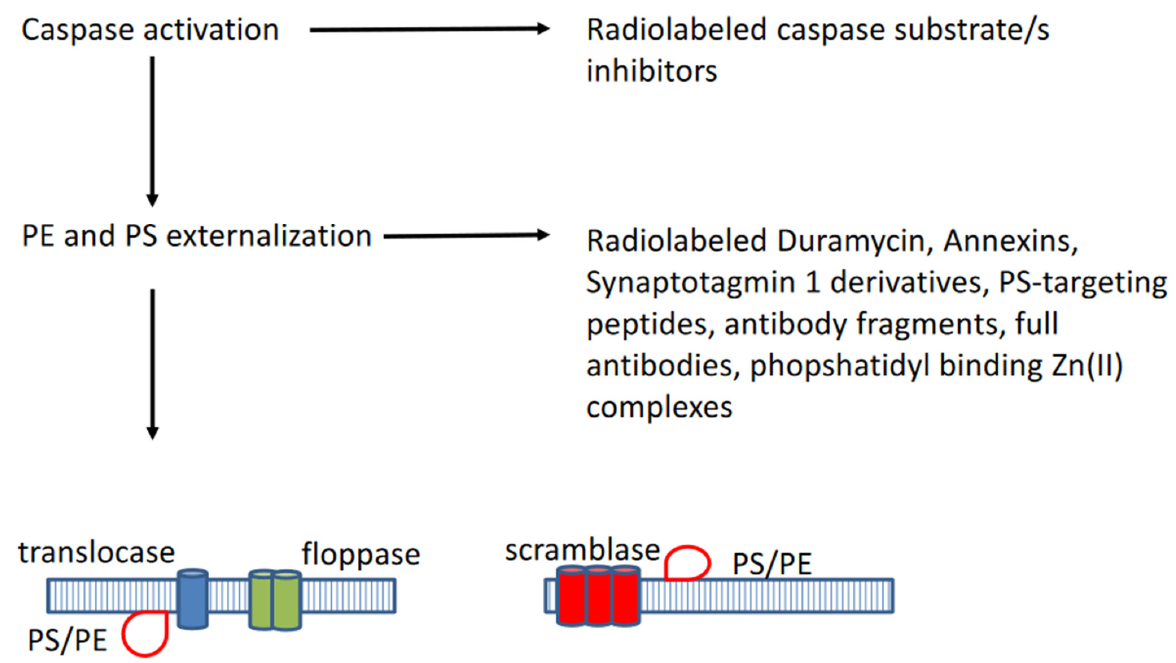
Figure 2. Following the activation of caspases, phosphatidylserine (PS) and phopshatidylethanolamine (PE) became externalized through activated enzymes such as translocase, floppase, and scramblase.